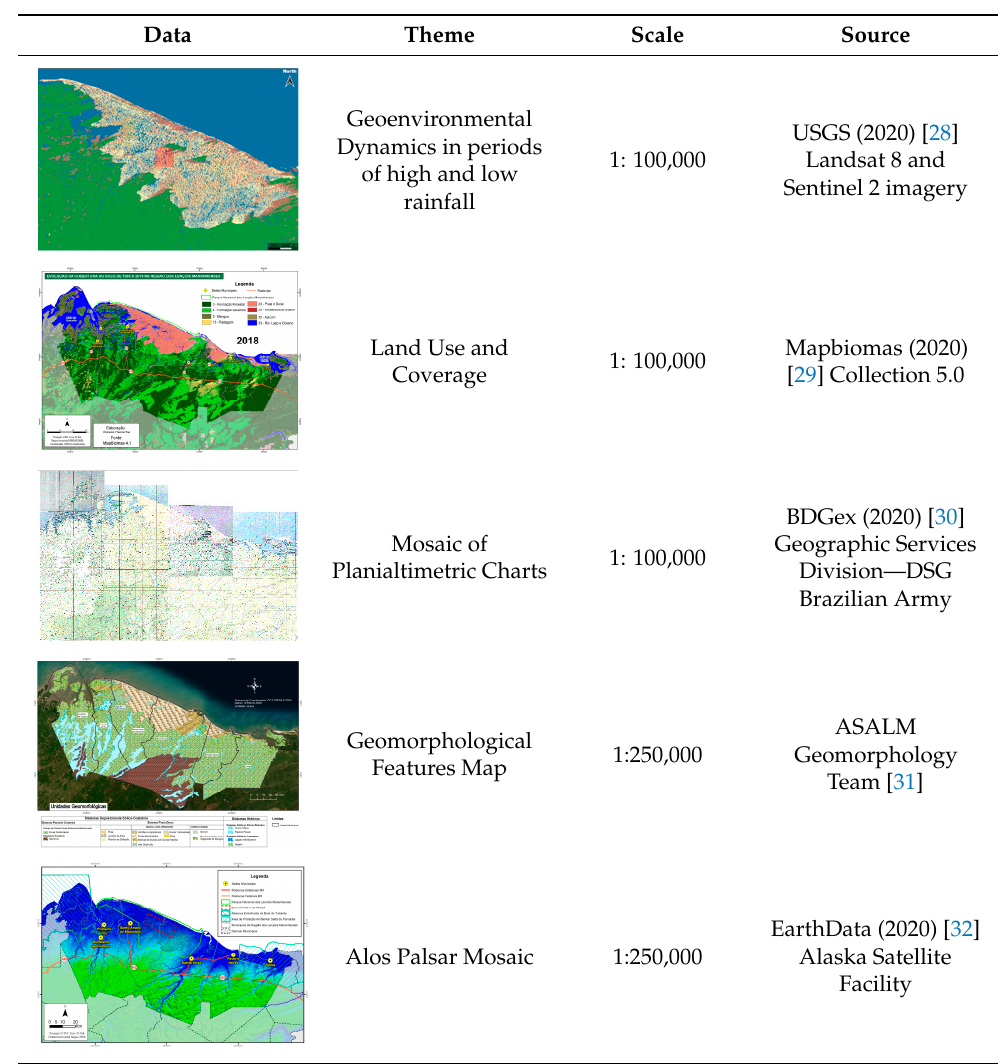
Table 1. Surveyed Geospatial Data, source and scale of origin of